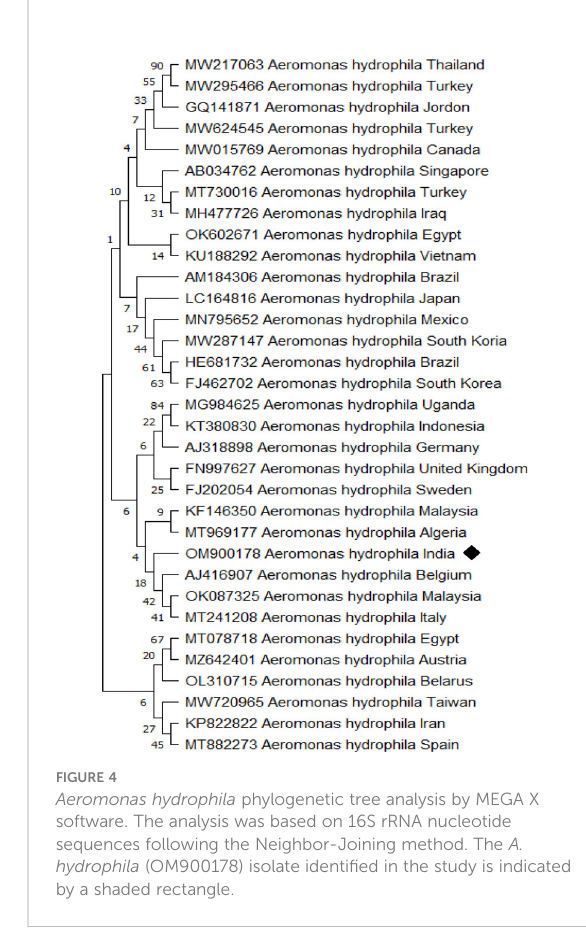
oil treatment signi fi cantly induces high toxicity, and 60% – 100% moratlity was observed in the group. Interestingly, the turmeric